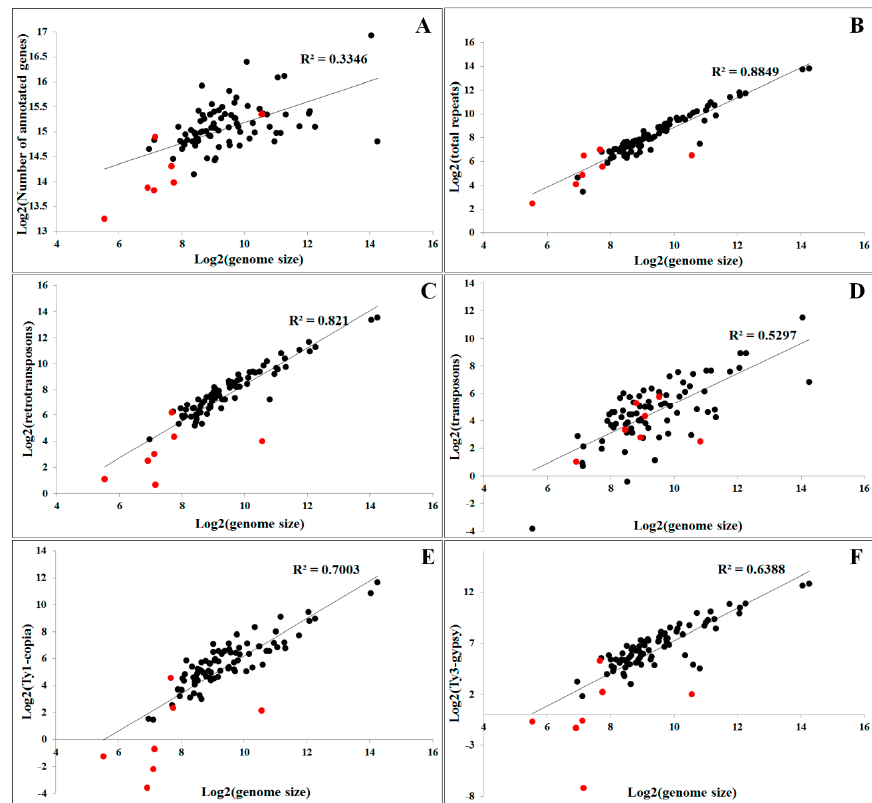
Figure 2. Correlation analysis between genome size and gene numbers or quantities of different types of repetitive sequences in plants. ( A ) genome size versus genes; ( B ) genome size versus repetitive sequences; ( C ) genome size versus retrotransposons; ( D ) genome size versus transposons; ( E ) genome size versus Ty1- copia elements; ( F ) genome size versus Ty3- gypsy elements. This figure is drawn based on the data presented in Table S1. The black dots represent the analysis from data of higher plants, whereas the red dots indicate the analysis from data of lower algal